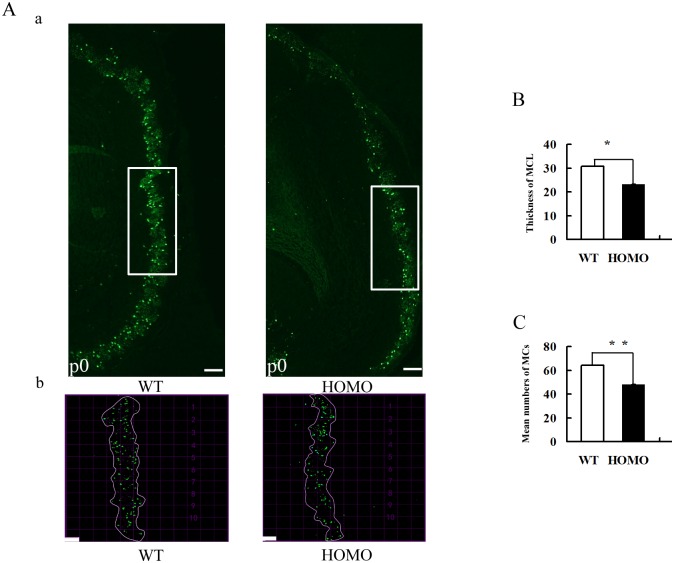
Morphometric analysis of MCL thickness and number of MCs in WT and mutants at P0.(A) Representative micrographs showing Tbx21-positive MCs in the OB (green). Appropriate grids (20×20μm) were applied, and the average thickness of the MCL was calculated from the measurement at 10 grid lines that marked, (b) Boxed region in (a). (B) Bar graph indicating that the thickness of the MCL in Lgl1 mutants was significantly decreased compared with that of WT mice at P0 (means±se, *P<0.05, **P<0.01, paired t test, 9 mice/group;). (C) The graph shows that the mean number of MCs in Lgl1 mutants was significantly different from that of WT mice (means±se, *P<0.05, **P<0.01, paired t test, 9 mice/group;). Scale bars represent 200 μm (A, a), 20 μm(A, b).